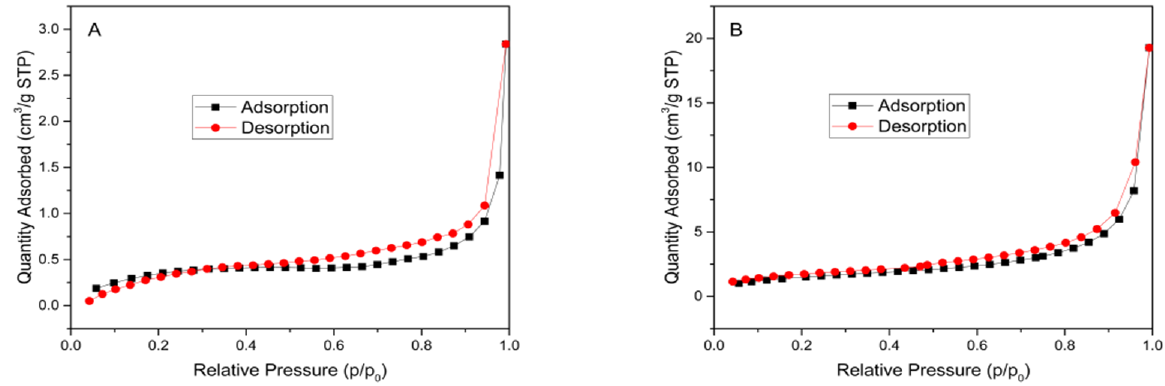
Figure 3. FTIR spectra of RH and TiO 2 -RH.